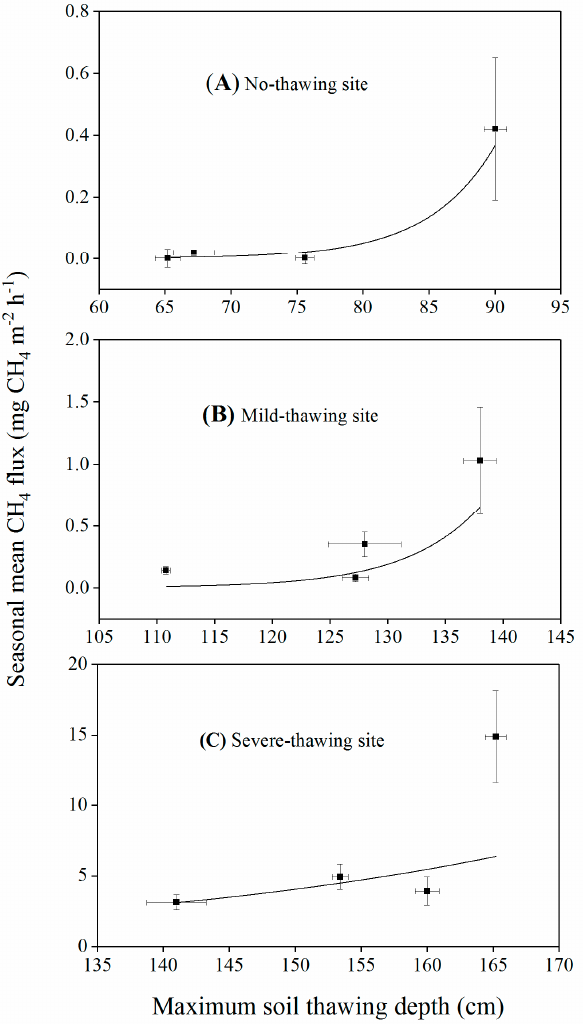
Figure 6. Relationship between seasonal mean CH 4 flux and annual maximum soil thawing depth in no-thawing ( A ), mild-thawing ( B ) and severe-thawing ( C ) sites.